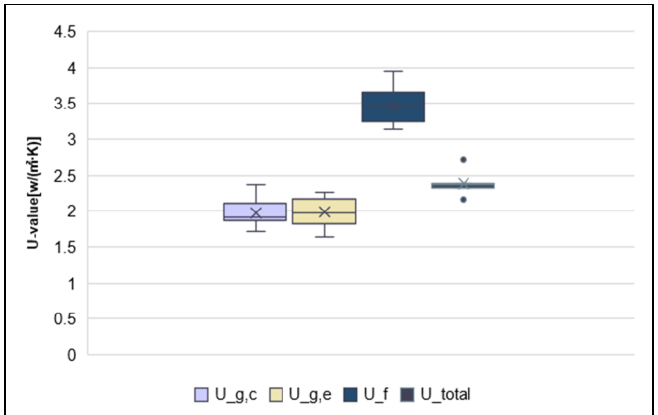
Figure 25. Boxplot of U-value Results Using HFM Method [36].